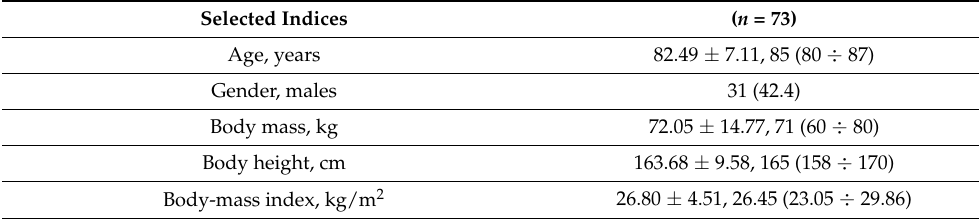
Table 1. Initial clinical characteristics.